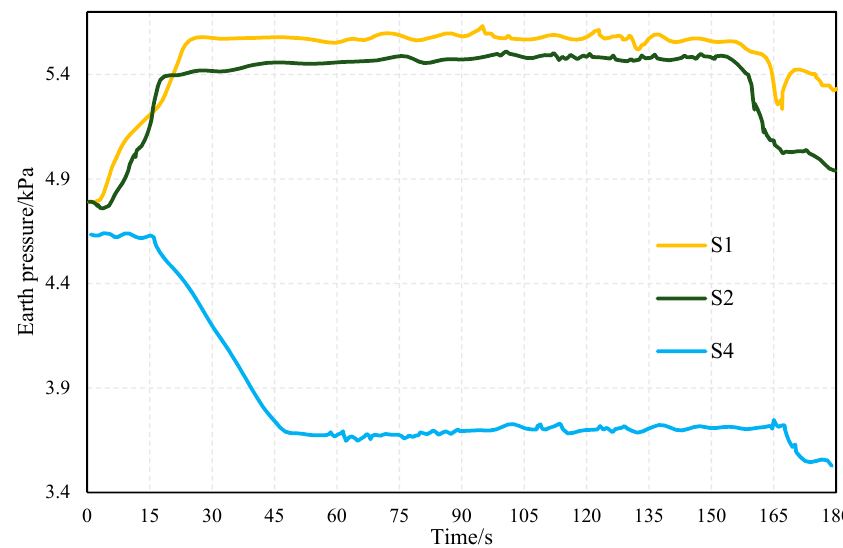
Figure 20. Measured soil pressure in Model 13-15.